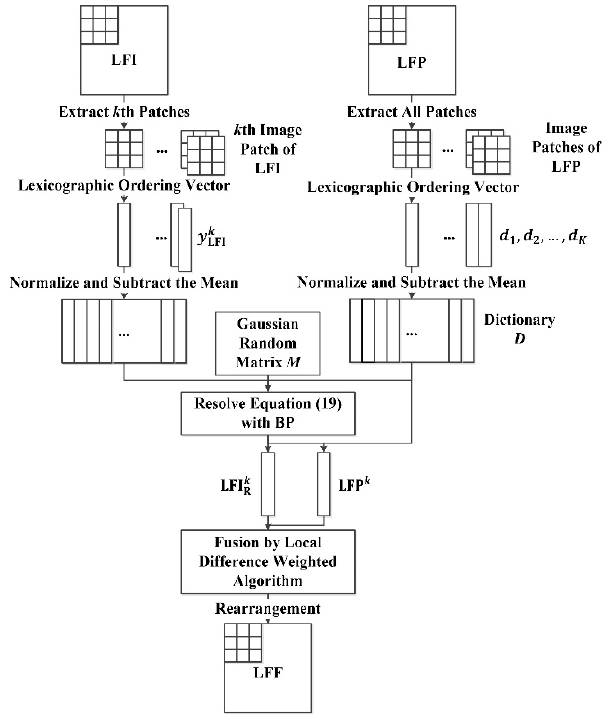
Figure 1. The procedure of low-frequency sub-images fusion.